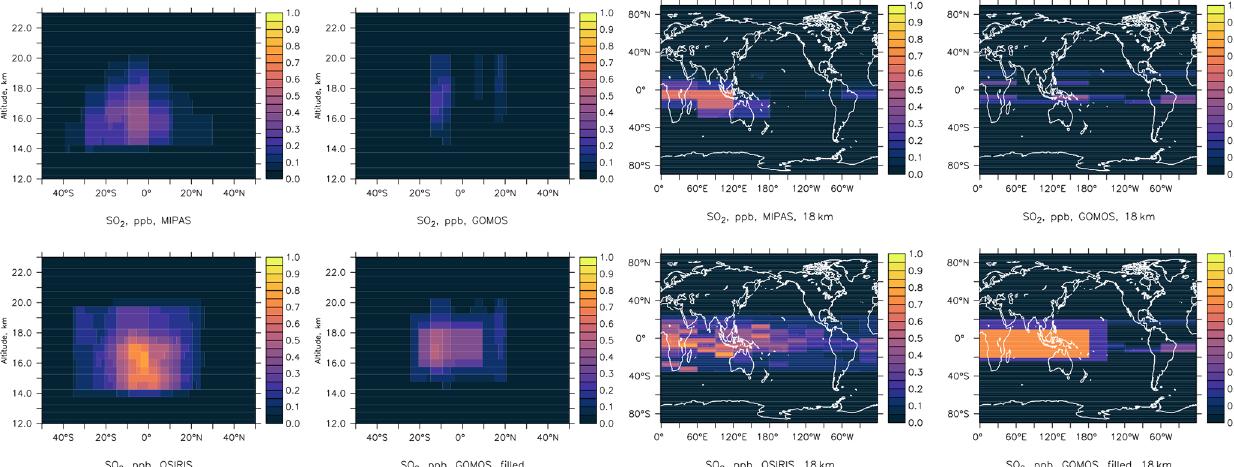
Figure B2. 2010 Merapi eruption: SO 2 mixing ratio perturbation (ppb) derived from MIPAS, GOMOS OSIRIS and GOMOS with gap filling. MIPAS data 5 to 20 November 2010, OSIRIS 14 to 25 November, and GOMOS 25 November to 9 December (sparse data). Zonal average vertical distribution (left) and plumes at 18km altitude (right).